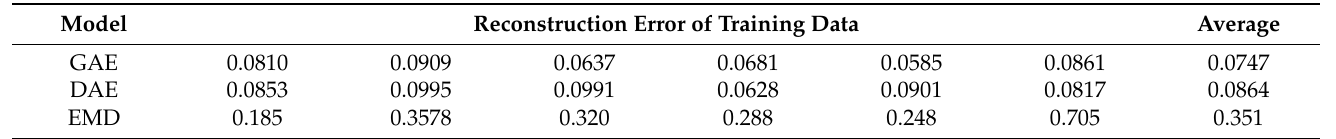
Table 11. Reconstruction errors of training